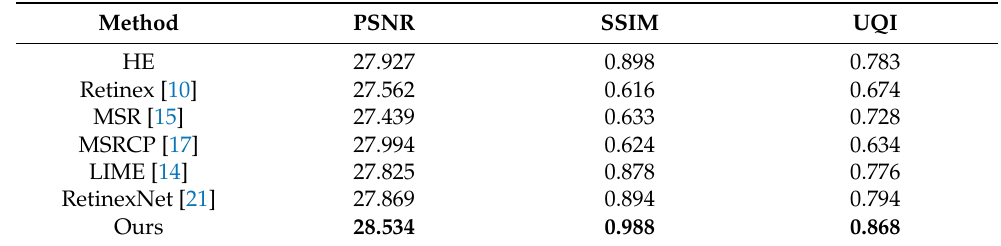
Table 1. Quantitative comparison of the results of each method. The bold numbers indicate the best